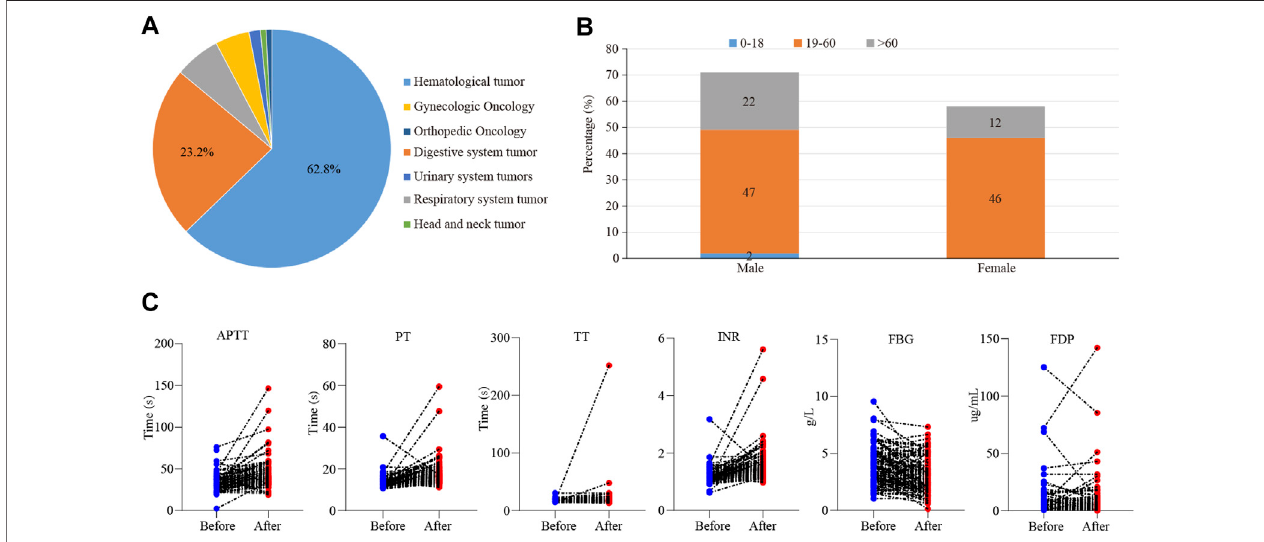
FIGURE 1 | The effect of tigecycline on coagulation in tumor patients. (A) The pie analysis of types of cancers involved in this retrospective analysis. (B) The statistical histogram of gender and age of the patients treated with tigecycline. (C) The blood coagulation indexes of hematological tumor patients before and after tigecycline treatment.